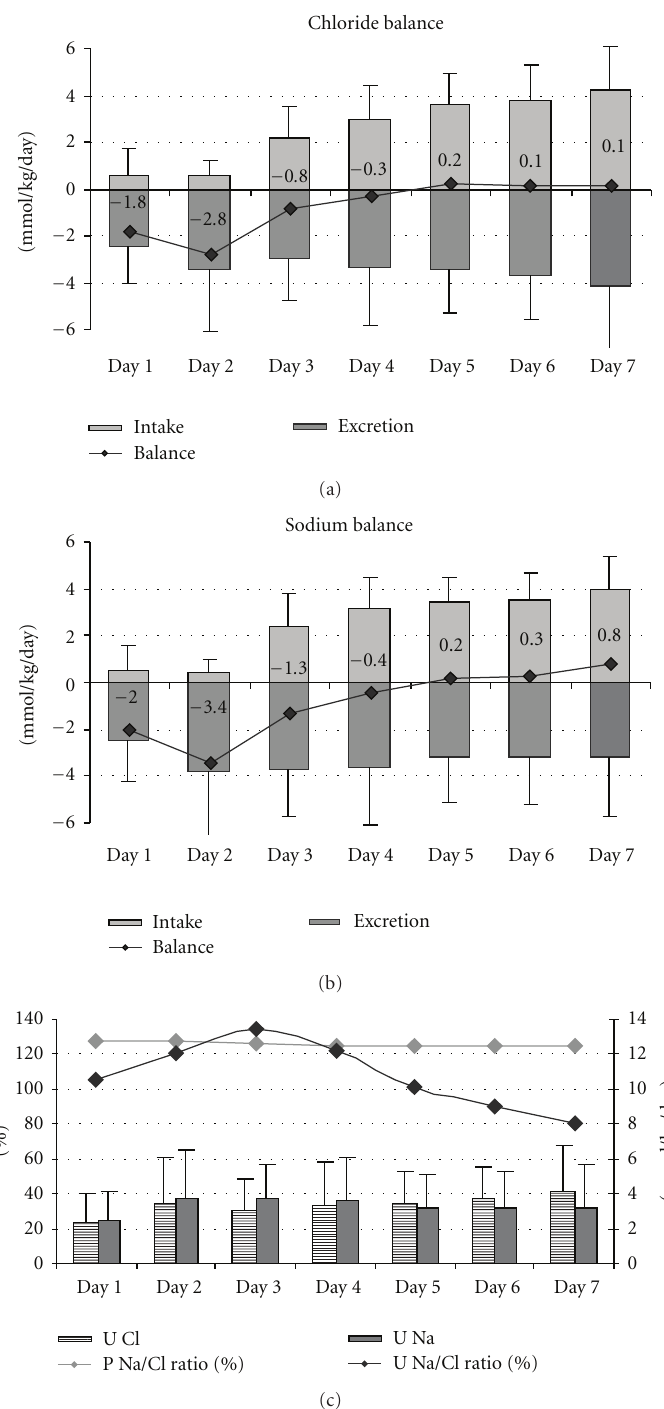
Figure 1: Chloride and sodium intake and balance during the first week of life in 107 infants < 33 weeks of GA hospitalized in NICU.